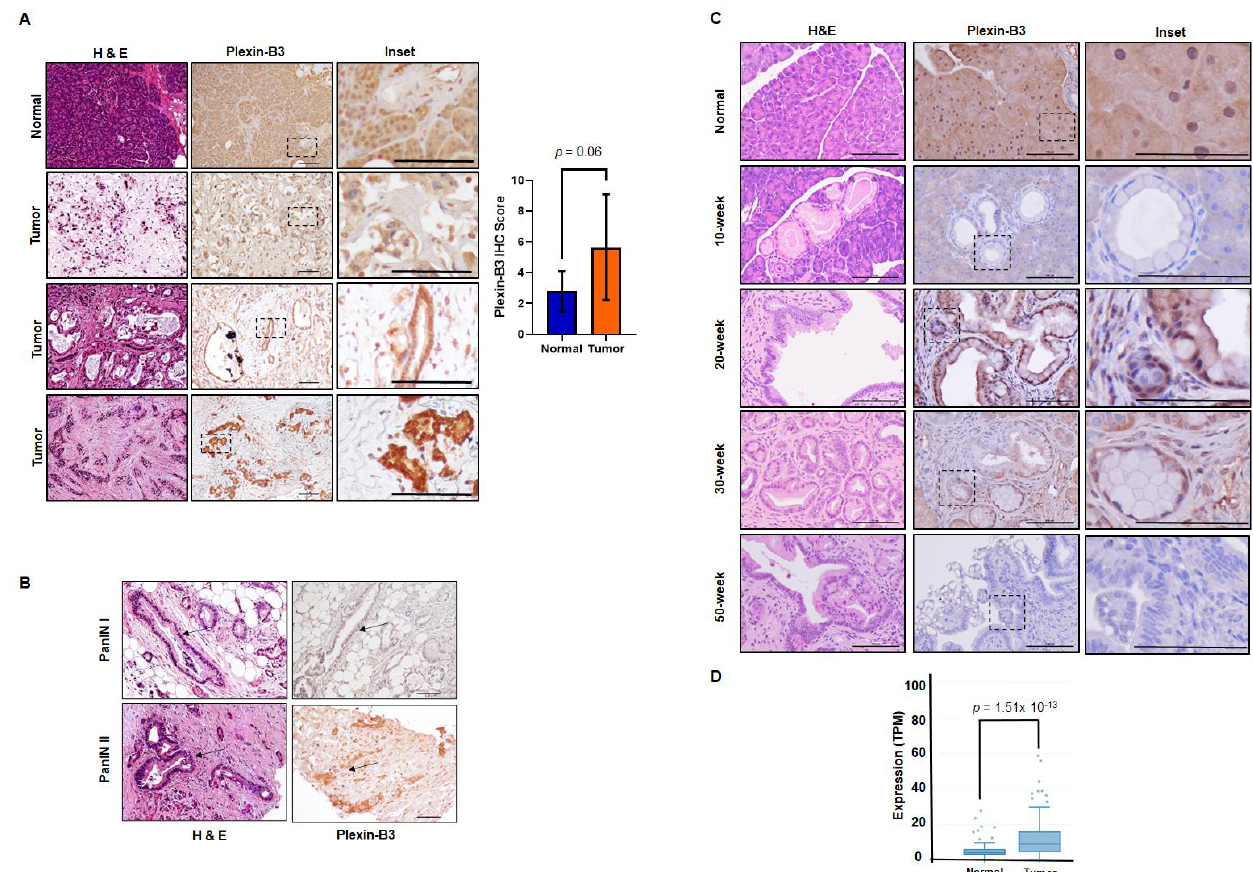
Figure 1. Pathological expression of Plexin-B3 in pancreatic cancer (PC). ( A ) Representative images of Plexin-B3 Immuno- histochemistry (IHC), along with the corresponding Hematoxylin and eosin stain (H&E) of the normal human pancreas and tumor cores present in the tissue microarray. The pictorial graph demonstrates the different intensities of Plexin-B3 staining in pancreatic tumor tissues. The normal pancreas is positive for the expression of Plexin-B3. The scale bar represents 100 µ m. Bar graph showing higher Plexin-B3 IHC scores in the tumor in comparison with a normal pancreas. ( B ) Representative images demonstrating Plexin-B3-positive PanIN I and II lesions in tumors. The scale bar represents 100 µ m. ( C ) Representative images of Plexin-B3 IHC performed on a progression model derived from tumors of Pdx1-cre; LSL-Kras (G12D) (KC) mice ( n = 5) at different ages (10, 20, 30, and 50 weeks). The pictorial graph demonstrates a progressive increase in qualitative Plexin-B3 expression in cancerous lesions of the KC mice model until 20 weeks, followed by a loss of expression in the later stages of pancreatic ductal adenocarcinoma (PDAC). The normal pancreas of 50-week-old Pdx1-cre mice are positive for Plexin-B3 expression. The scale bar represents 100 µ m. ( D ) Plexin-B3 gene expression analysis in the online Michigan Portal for the Analysis of NGS Data (MiPanda) showing a higher Plexin-B3 expression ( p = 1.51 × 10 − 13 ) in pancreatic tumors ( n = 419) in comparison with a normal